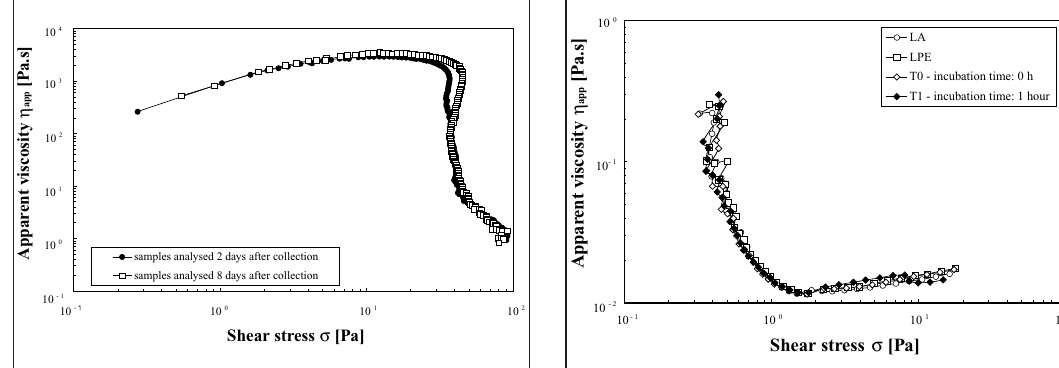
Figure 7 (left): Representative plot of apparent viscosity versus shear rate (upward cycle) of T3 yoghurt sample in function of storage time. Figure 8 (right): Representative plot of apparentviscosity versus shear stress (upward cycle) of milk and yoghurt sam- ples during different stages of set-style